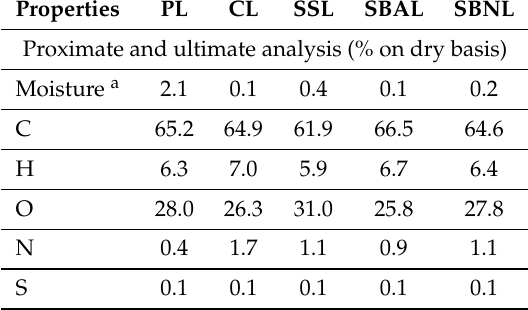
Table 1. Proximate and ultimate analysis of lignin that was fractionated from cotton, sweet sorghum, pine sawdust, spruce bark (with and without the acid catalyst). The abbreviations of lignin fractionated from pine sawdust (PL), cotton stalks (CL), sweet sorghum bagasse (SSL), spruce bark with (SBAL) and without acid addition (SBNL) were used. The standard error for all measurements was < 10% of the